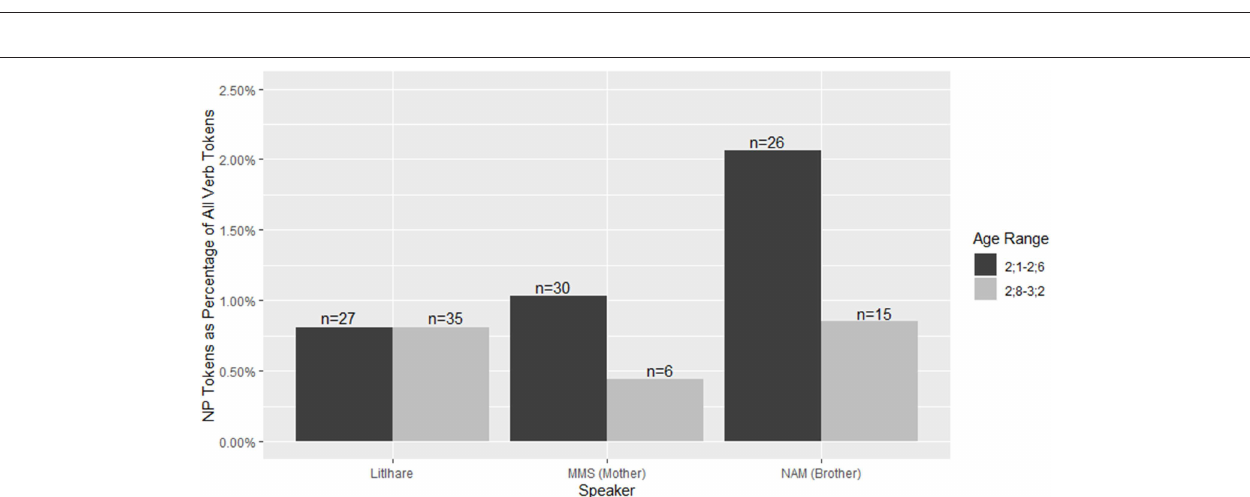
FIGURE 1 | Percentage of narrative past tokens of all verb tokens in the Hlobohang sub-corpus.